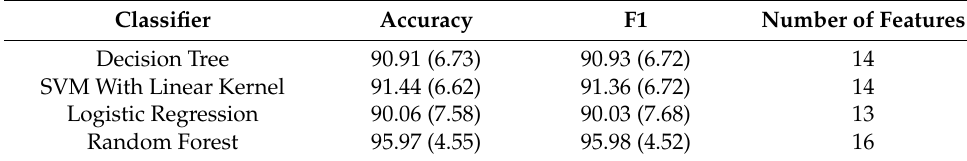
Table 1. Classification results for a selected feature subset.